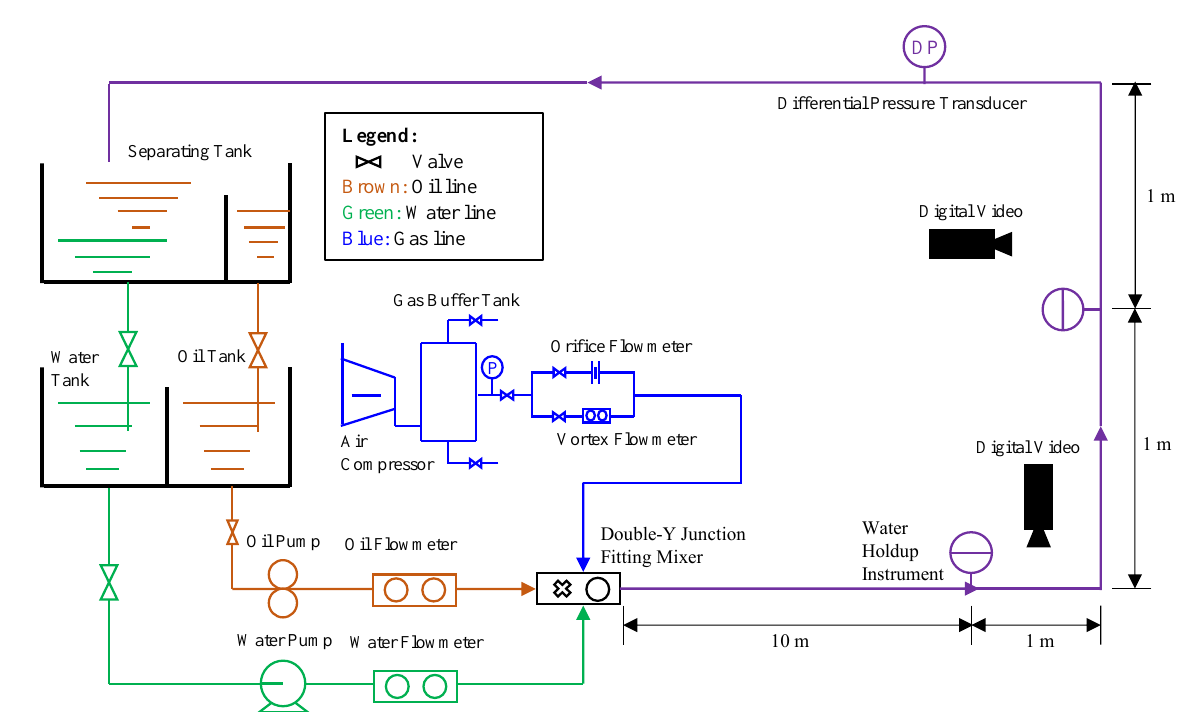
Figure 1. Schematic drawing of the flow loop for the oil – water – gas three-phase flow used in this study. Table 1. Properties of water, oil, and gas phases measured at atmospheric pressure and 20 °C [20].